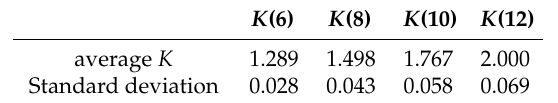
Table 3. Ratio of characteristic curve and baseline at different distances (in cm).